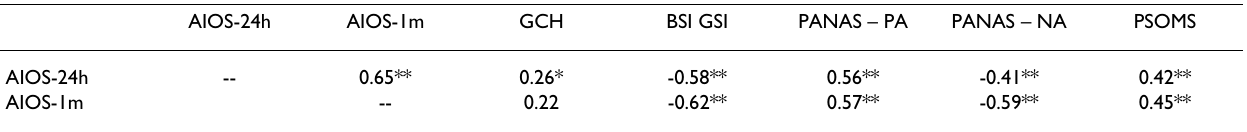
Table 6: Correlations between the AIOS and Measures of Global Health Ratings, Psychological Distress, Positive Affect, Negative Affect, and Positive States of Mind (N =